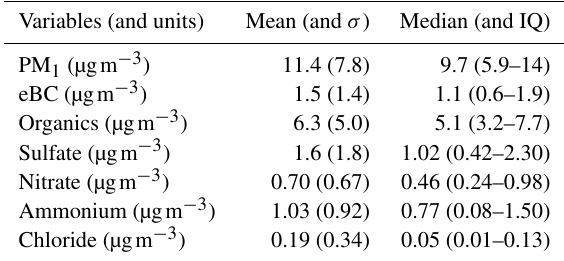
Table 2. Summarized statistics of near real-time aerosol measure- ments (PM 1 and its individual constituents) from 20 December 2016 to 15 March 2017. Statistics includes mean concentration, SD ( σ ), median, and interquartile interval